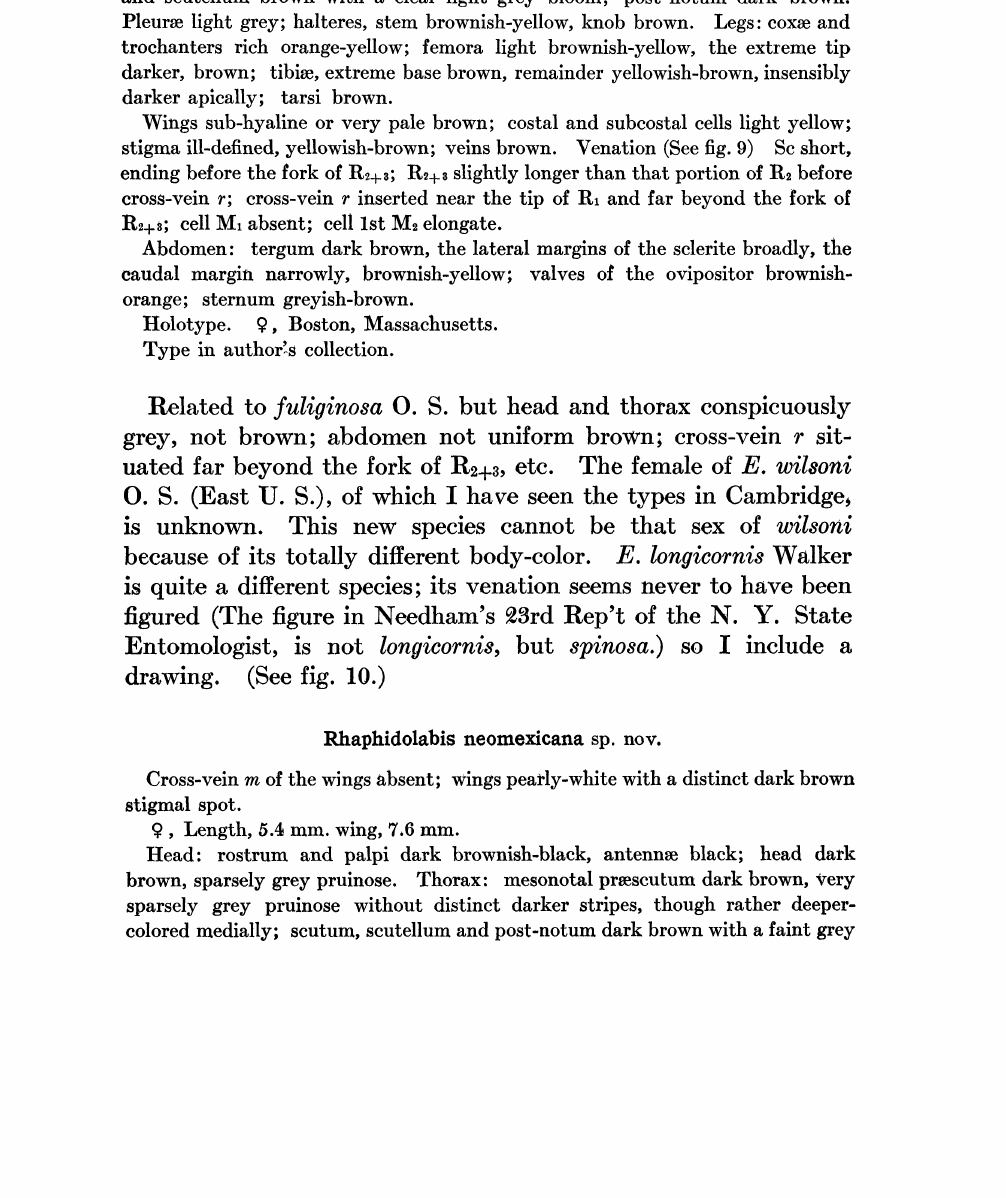
and two, light orange-yellow beneath, light brown above; flagellar segments brown. Front and clypeus light orange-yellow; vertex and occiput light grey, more brown- ish medially, paler on the vertex behind the eyes, and on the gena. Thorax: prothorax, scutum dark brown with a grey bloom and prominent pale hairs; scutellum dark brown medially, the ends conspicuously orange-yellow. M:esothorax yellowish-grey, the prmscutum with four very indistinct darker lines; the middle pair long, confluent or nearly so at their cephalic ends; lateral pair short, beginning behind the prominent rounded, black pseudo-suturalfovea; scutum and scutellum brown with a clear light grey bloom; post-notum dark brown. Pleurm light grey; halteres, stem brownish-yellow, knob brown. Legs: coxe and trochanters rich orange-yellow; femora light brownish-yellow, the extreme tip darker, brown; tibiae, extreme base brown, remainder yellowish-brown, insensibly darker apically; tarsi brown. Wings sub-hyaline or very pale brown; costal and subcostal cells light yellow; stigma ill-defined, yellowish-brown; veins brown. Venation (See fig. 9) Sc short, ending before the fork of R+8; R+ slightly longer than that portion of R,. before cross-vein r; cross-vein r inserted near the tip of R1 and far beyond the fork of R+a; cell M1 absent; cell 1st M,. elongate. Abdomen: tergum dark brown, the lateral margins of the sclerite broadly, the caudal margin narrowly, brownish-yellow; valves of the ovipositor brownish- orange; sternum greyish-brown.